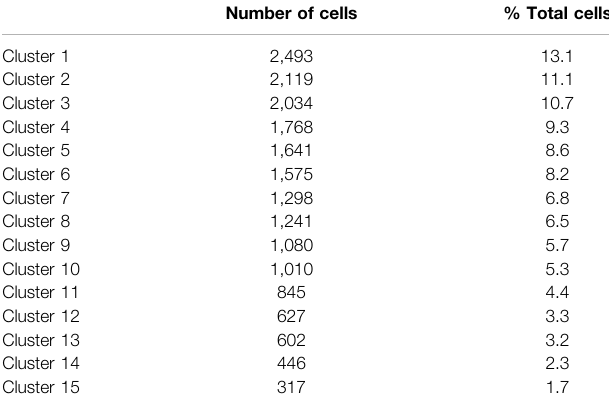
TABLE 2 | Numbers and percentages of clustered